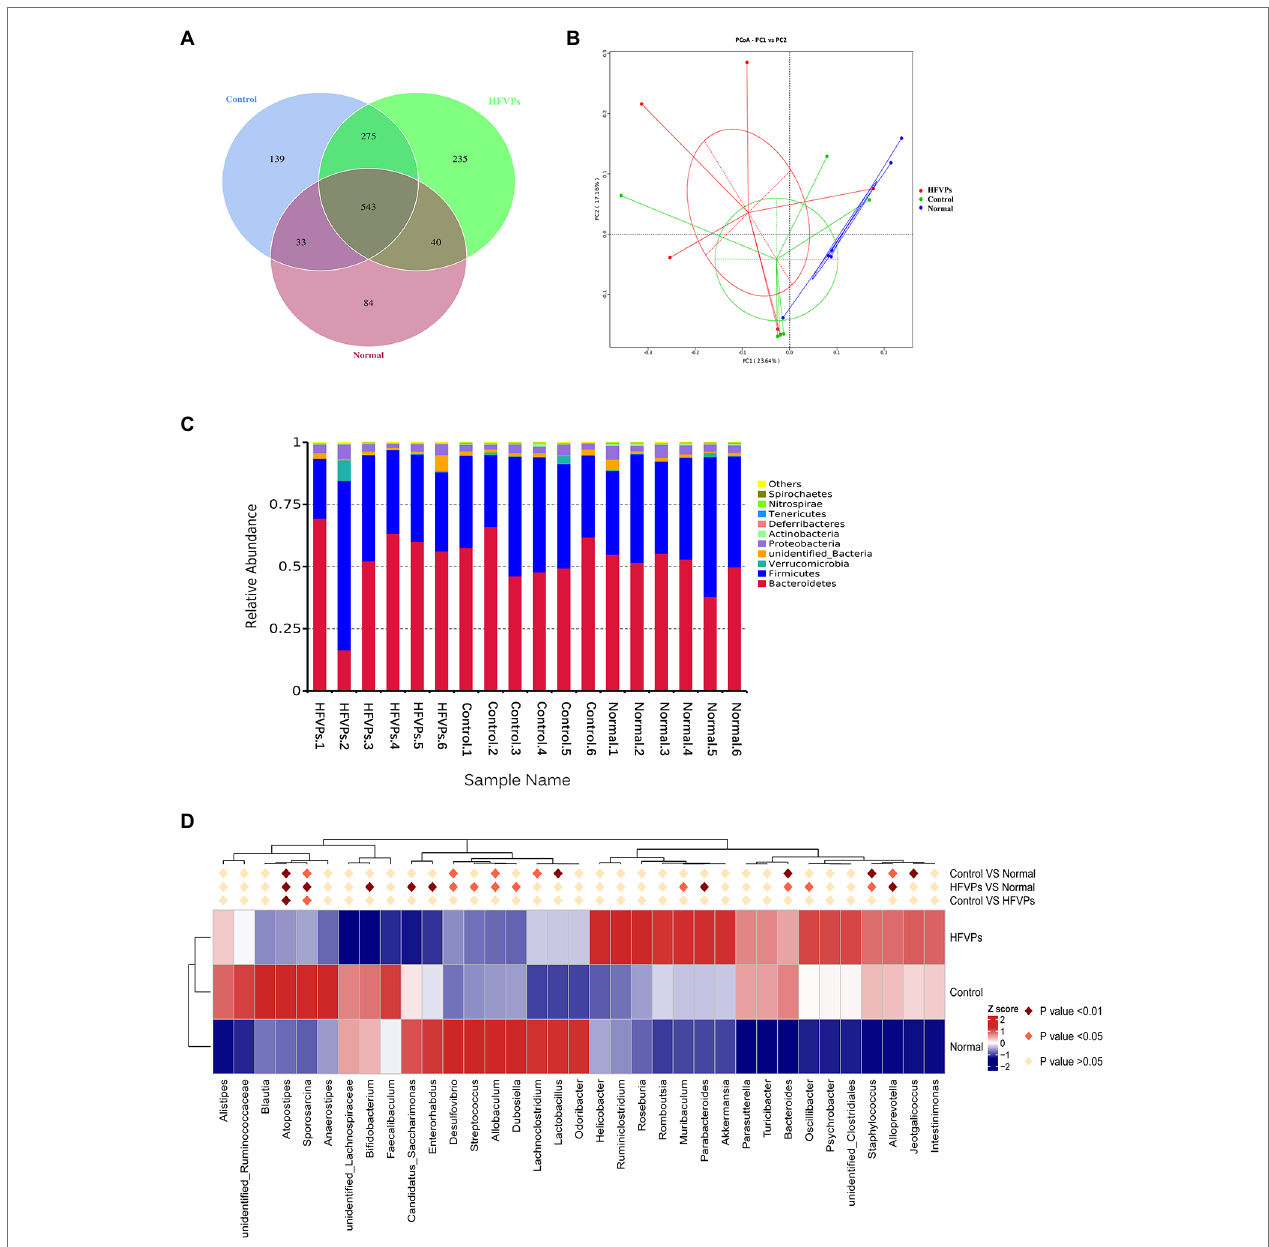
FIGURE 6 | (A) Venn diagram showing the number of operational taxonomic units (OTUs) in the Normal, Control, and HFVPs groups. (B) Principle coordinate analysis (PCA) plot used to evaluate the beta diversity parameters. Each point represents an individual specimen. (C) Microbial composition of the Normal, Control, and HFVPs groups at the genus level (top 20). (D) Heatmap of the significant differences in the gut microbiomes in the Normal, Control, and HFVPs groups at the genus level (obtained using the Metastats method). The data are presented in the form mean ± SD ( n =